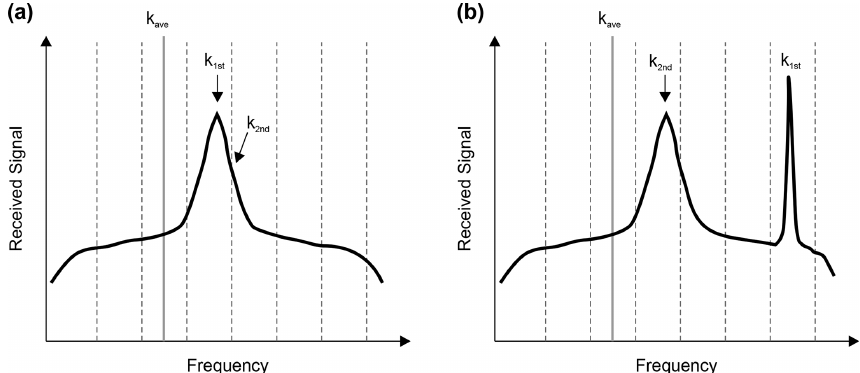
Figure 5. Conceptual explanation of the variables of simplified Kalman gain. (a) Correct measurement case of K = 1. (b) Case with the error peak of K = 0.